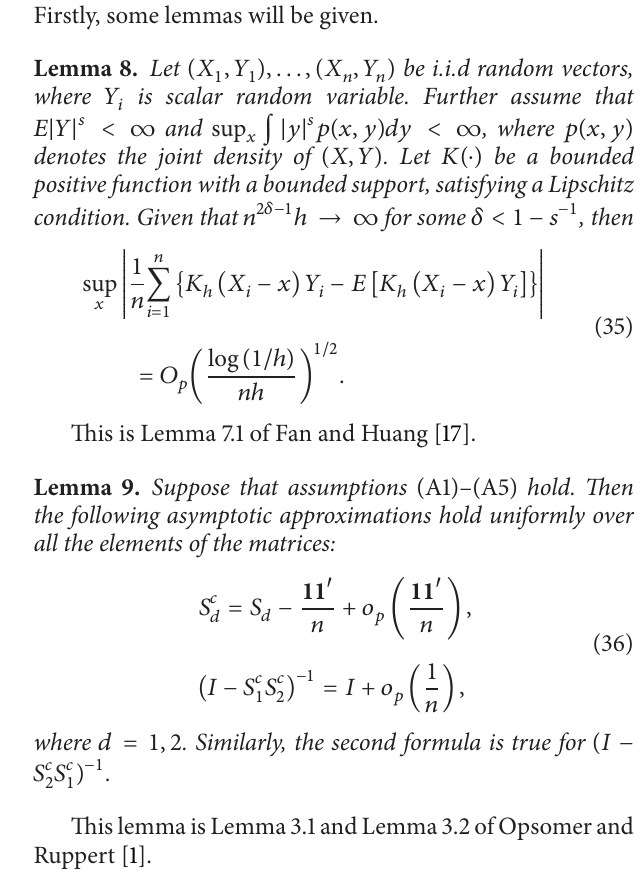
Table 1: The finite sample performance of the estimators for 𝑓 1 under different sample sizes 𝑛 and Σ 𝑢𝑢